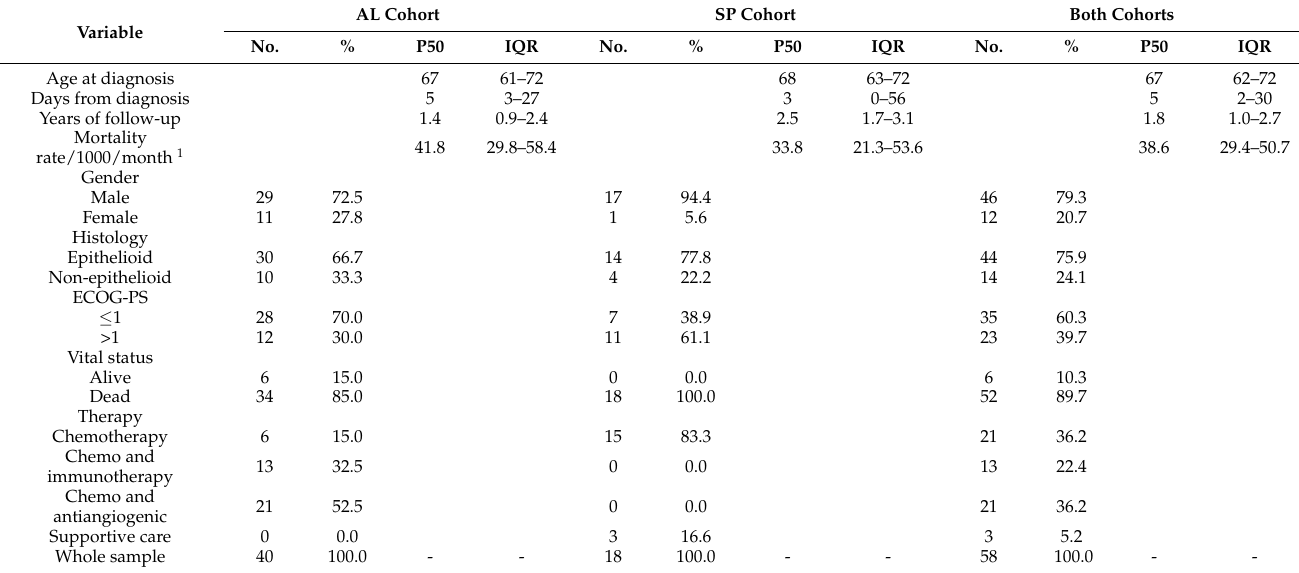
Table 1. Patients’ characteristics in MPM